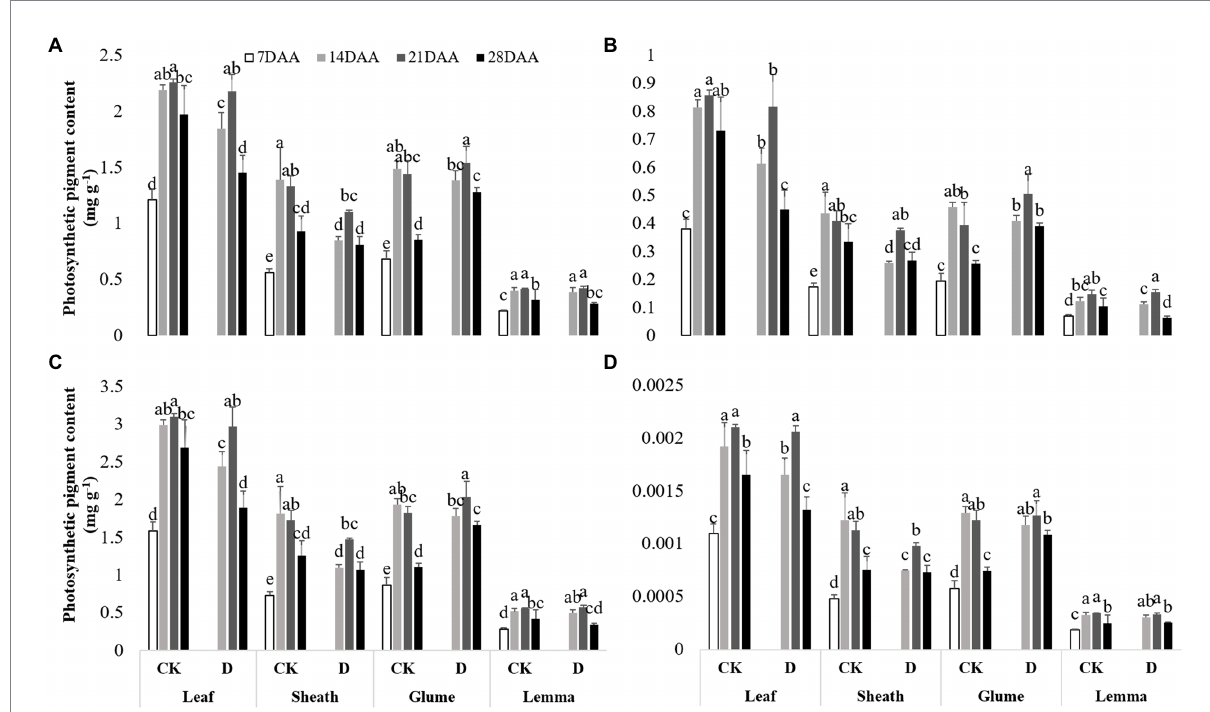
Different small letters within the same organ meant a significant difference at the 0.05 probability